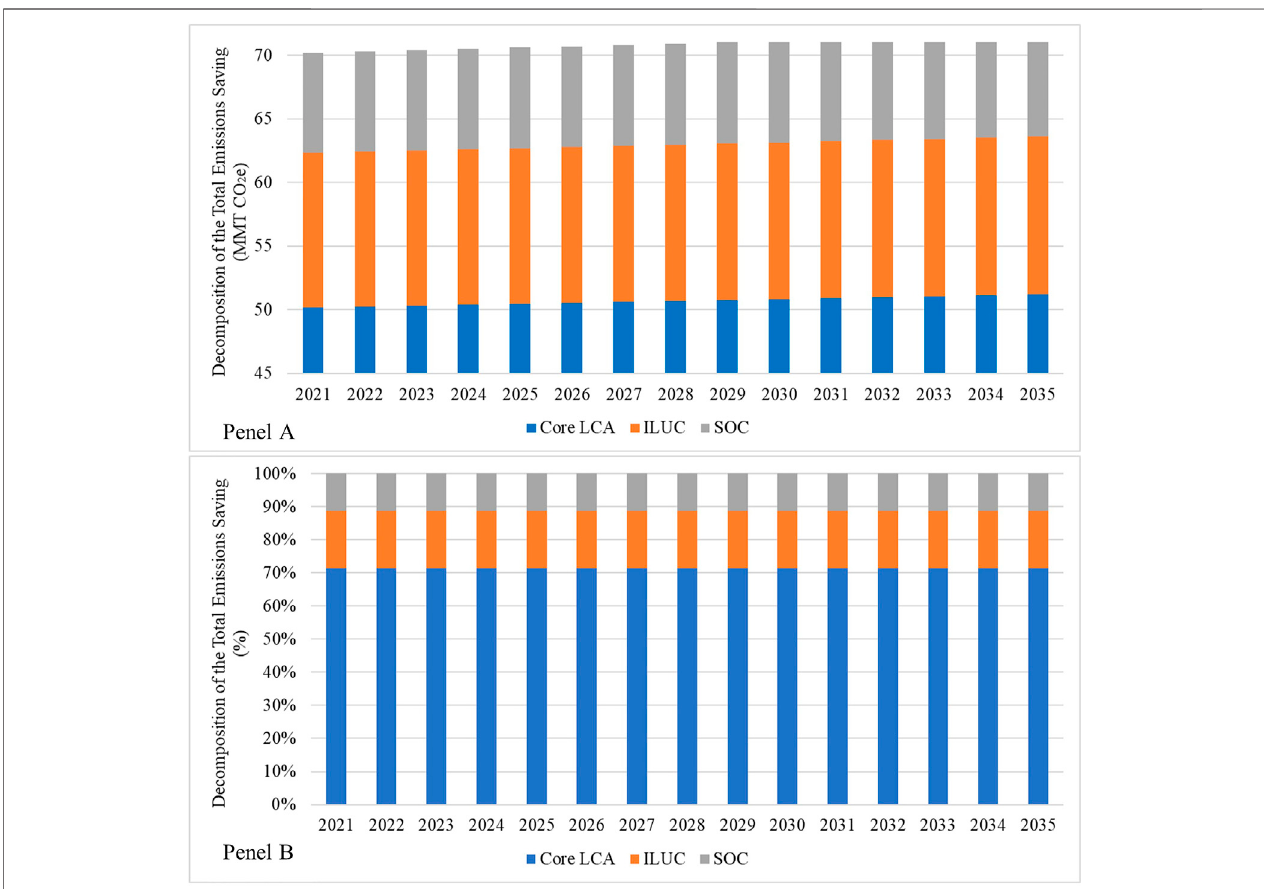
FIGURE 5 | Decomposition of the total emissions savings (third scenario); Panel (A) represents total emissions by types of emissions; Pent (B) represents emissions shares by types of emissions.